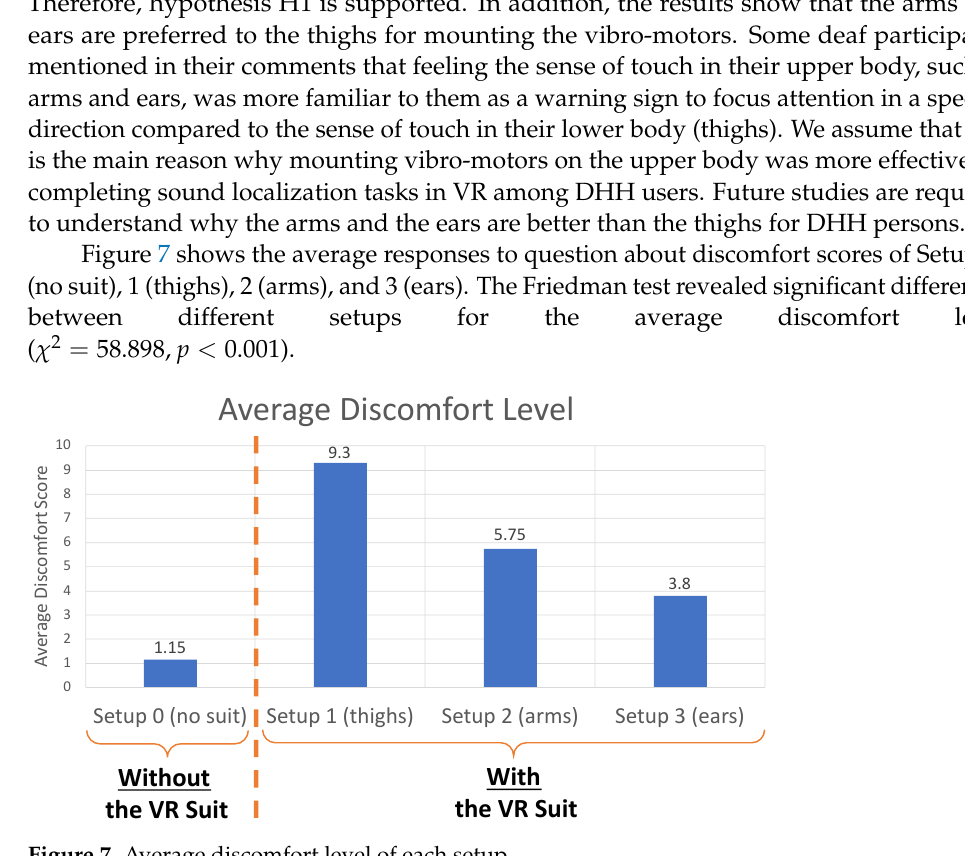
Figure 7. Average discomfort level of each